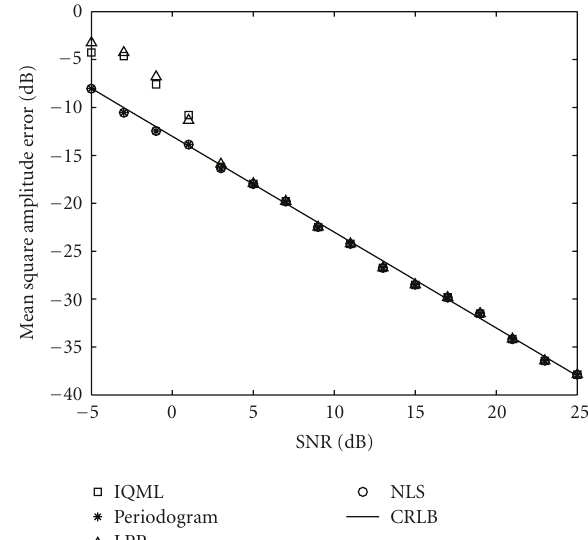
Figure 1: MSE for A of single complex sinusoid at N = 20.